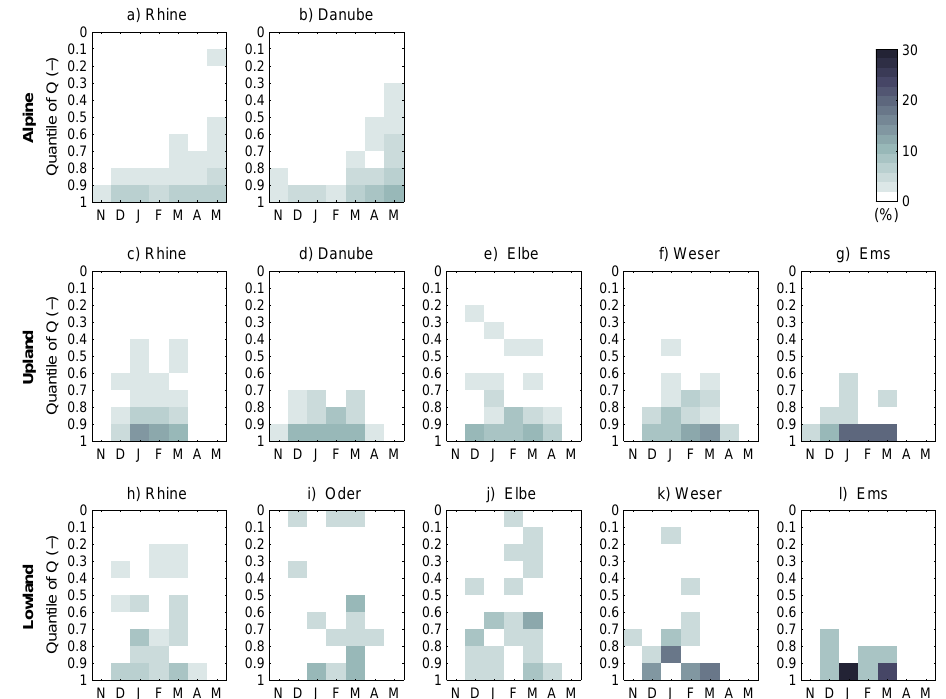
Figure 4. Percentage of potentially flood-generating RoS events from 1950 to 2011 by month of occurrence (November–May) and corre- sponding peak discharge